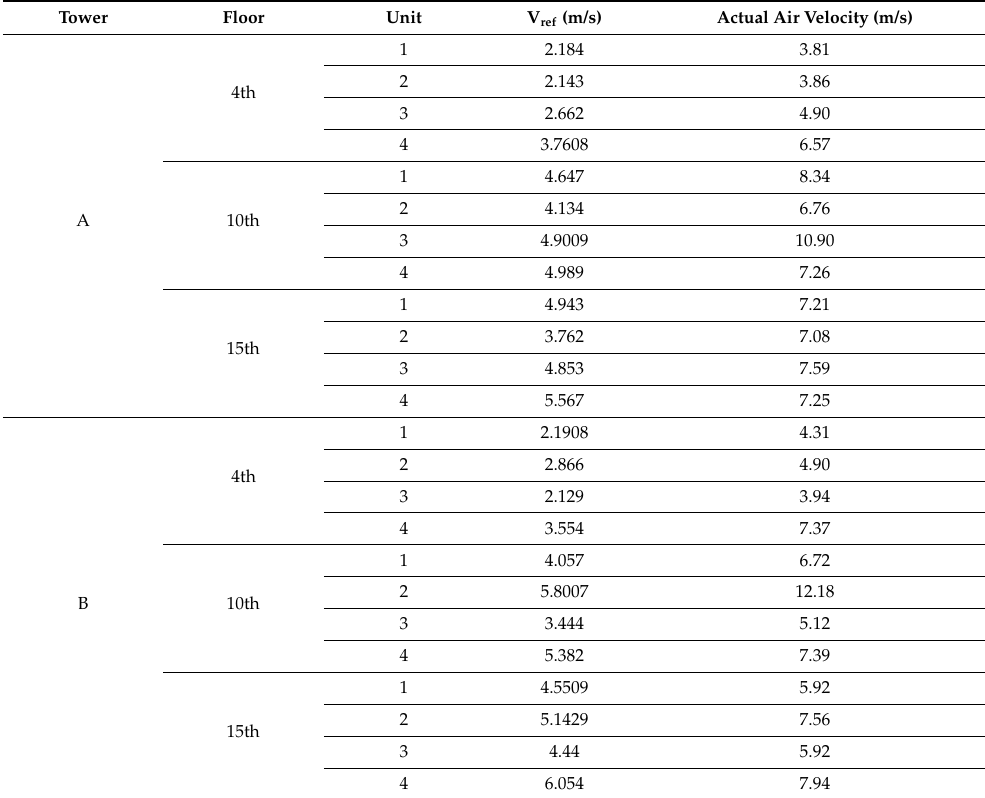
Table 9. Reference air velocity at the measured